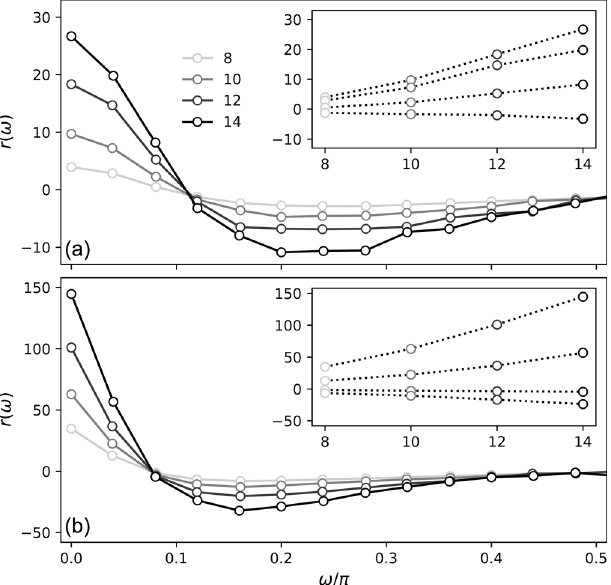
FIG. 21. Average correlator ¯ r ð ω Þ of single-site diagonal matrix elements in Haar-RFCs with (a) periodic and (b) open boundary conditions. The system size L is shown on the legend, and the smallest value of ω corresponds to an average over pairs of levels drawn from a quasienergy interval of width ω ≃ ð 2 . 5 × 10 − 3 Þ π . In the inset, we show the behavior of ¯ r ð ω Þ as a function of L for the four smallest values of ω in the main panels. The standard error in the correlator is of order